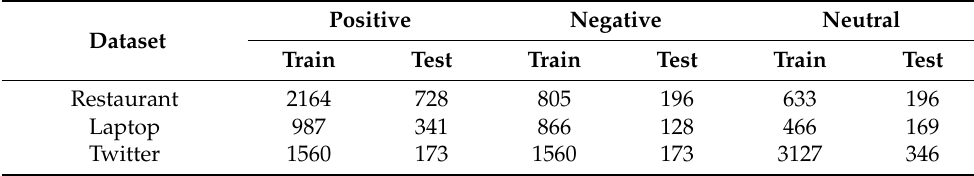
Table 1. Statistics of